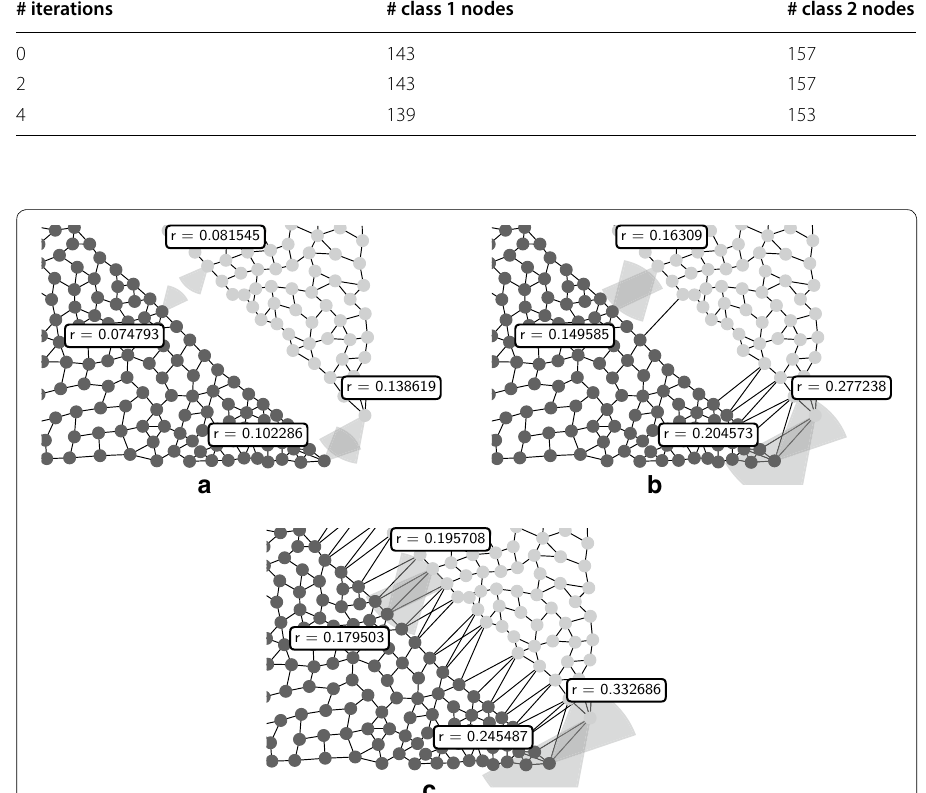
Fig. 5 Reach controlled graph knitting. Scaling constant R is 0.5, 1.0, and 1.25 in a – c , respectively. Zoomed view of dataset in Fig.